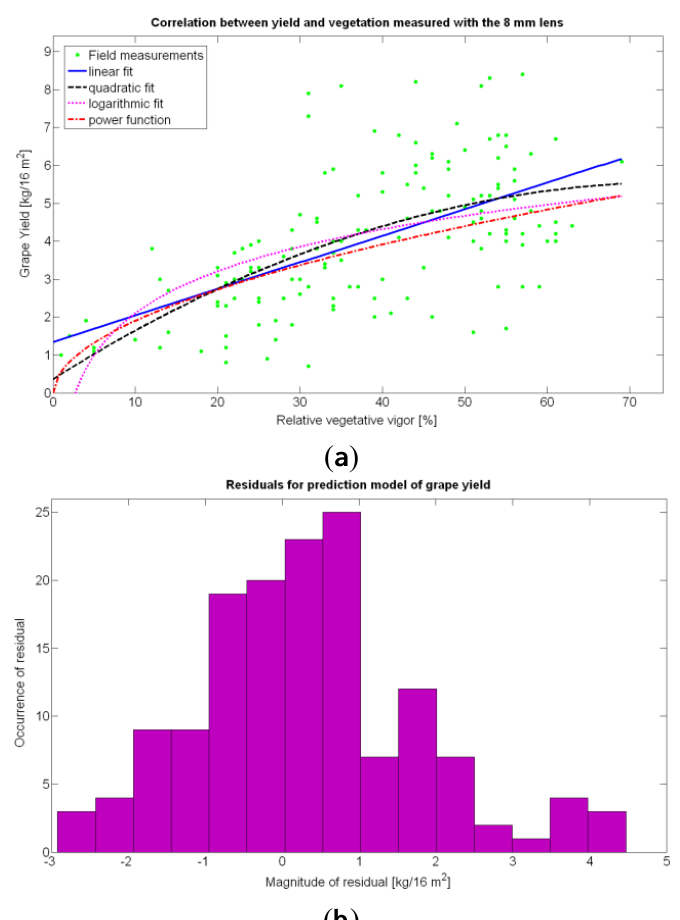
Figure 24. ( a ) Prediction models for yield as a function of V-8 relative vigor; ( b ) Residuals for predictive Model 15Y (power